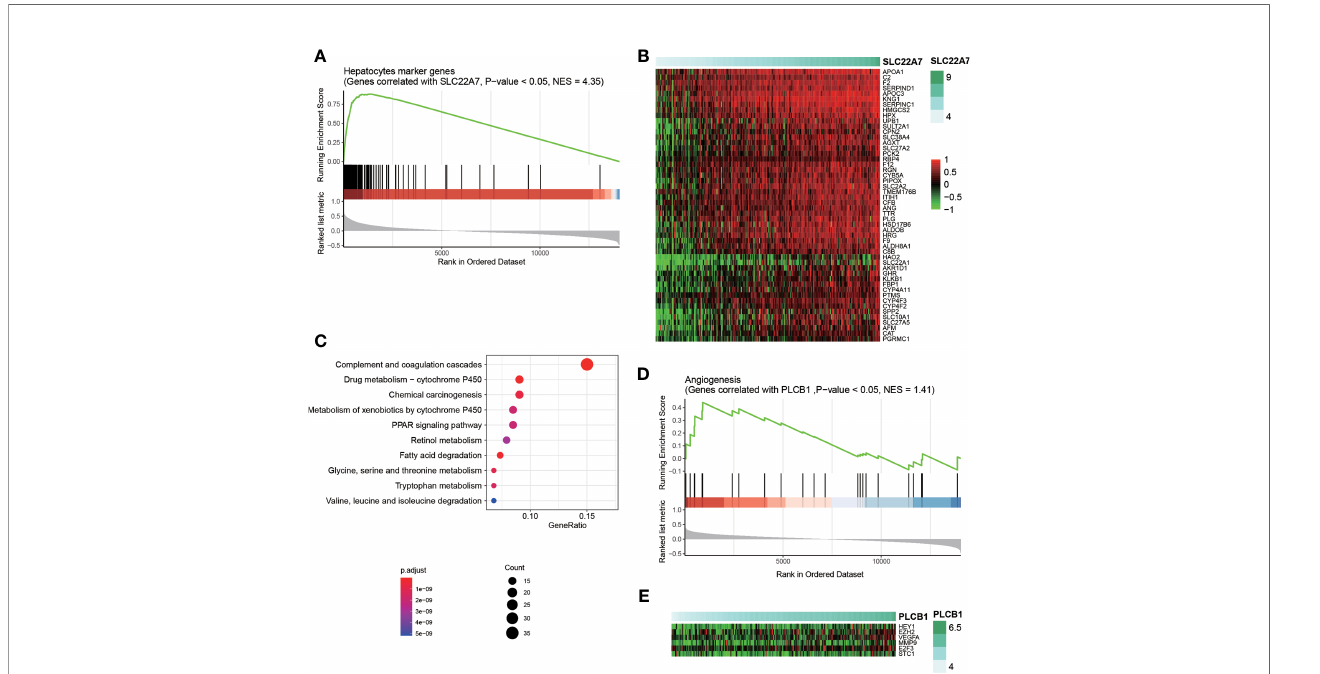
FIGURE 5 | Interpretation of SLC22A7 and PLCB1 in HCC recurrence. (A) The statistical signi fi cance of the genes correlated with SLC22A7 enriched in the hepatocytes marker genes. The y axis on the bottom represents the Spearman correlation coef fi cients. (B) The heatmap for the core genes positively correlated SLC22A7 and also speci fi cally expressed in hepatocytes. (C) The KEGG pathways enriched by the core genes positively correlated SLC22A7 and also speci fi cally expressed in hepatocytes. (D) The statistical signi fi cance of the genes correlated with PLCB1 enriched in the angiogenesis-related genes. (E) The heatmap for the core genes positively correlated PLCB1 and also involved in angiogenesis.